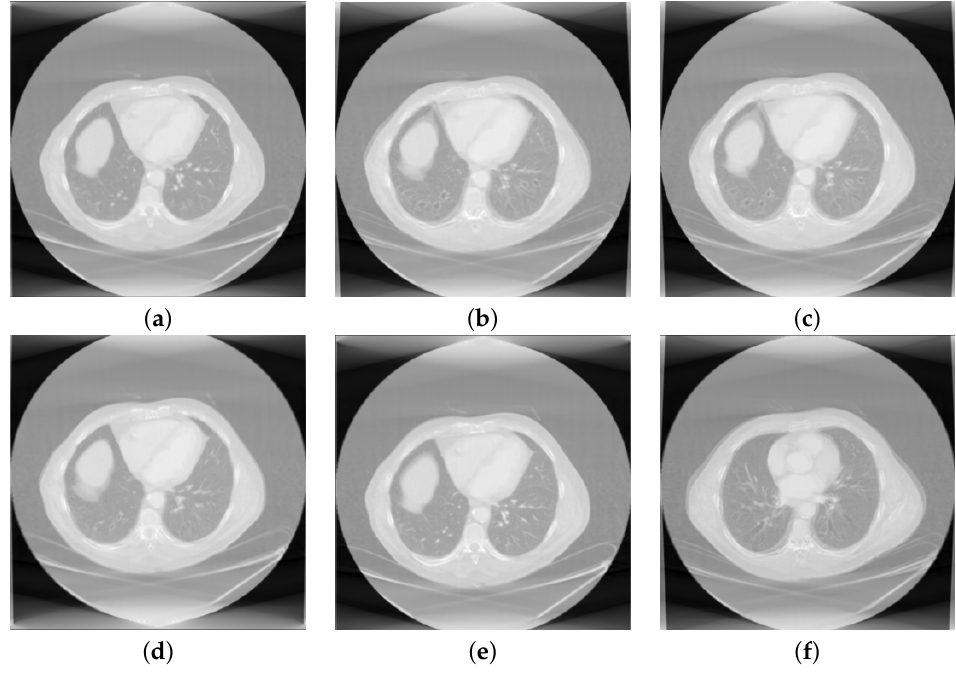
Figure 4. Slices of the reconstructed model at Td y = − 29.02 mm based on the rotation axis invari- ance method. ( a ) Case 1; ( b ) Case 2; ( c ) Case 3; ( d ) Case 4; ( e ) Case 5; ( f ) Case 6.